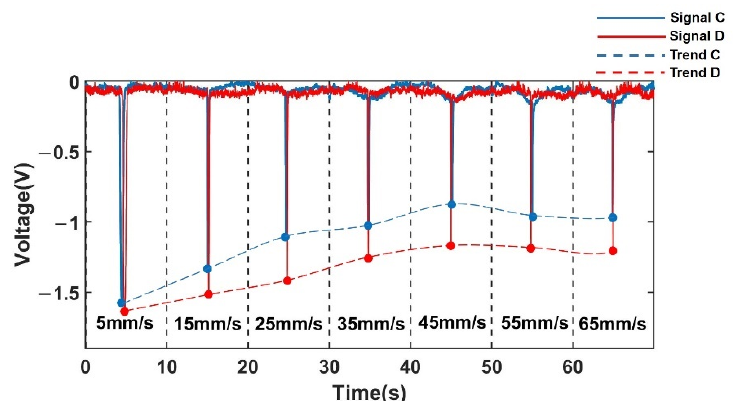
Figure 17. Signal change of non-ferromagnetic metal particles (350 µ m Cu) with velocity change after adjusting the detection